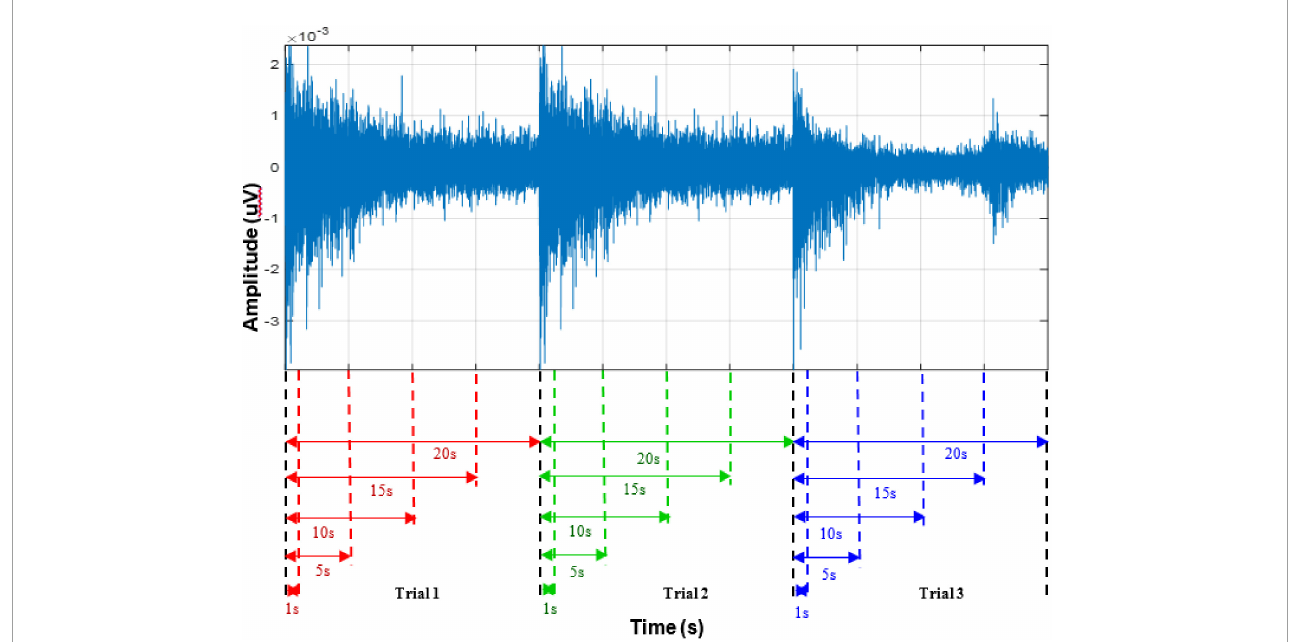
FIGURE2 Conceptualized diagram of varying signal recording lengths considered in the study for three trials.